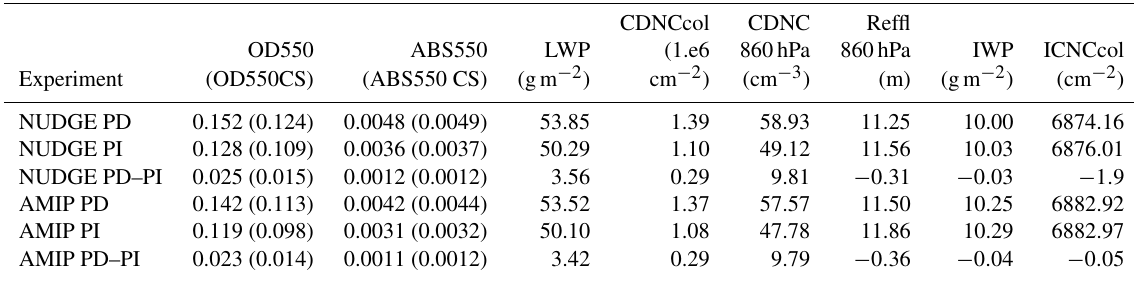
Table 11. All-sky and clear-sky aerosol optical depth (OD) and absorptive optical depth (ABS) at 550nm, liquid water path (LWP), in-cloud cloud droplet number concentrations (CDNCs)* and effective cloud droplet radius (Reffl)** at 860hPa (model layer 24), and ice water path (IWP). Also shown are the column-integrated CDNC (CDNCcol) and ice crystal number concentration values (ICNCcol, calculated as part of the